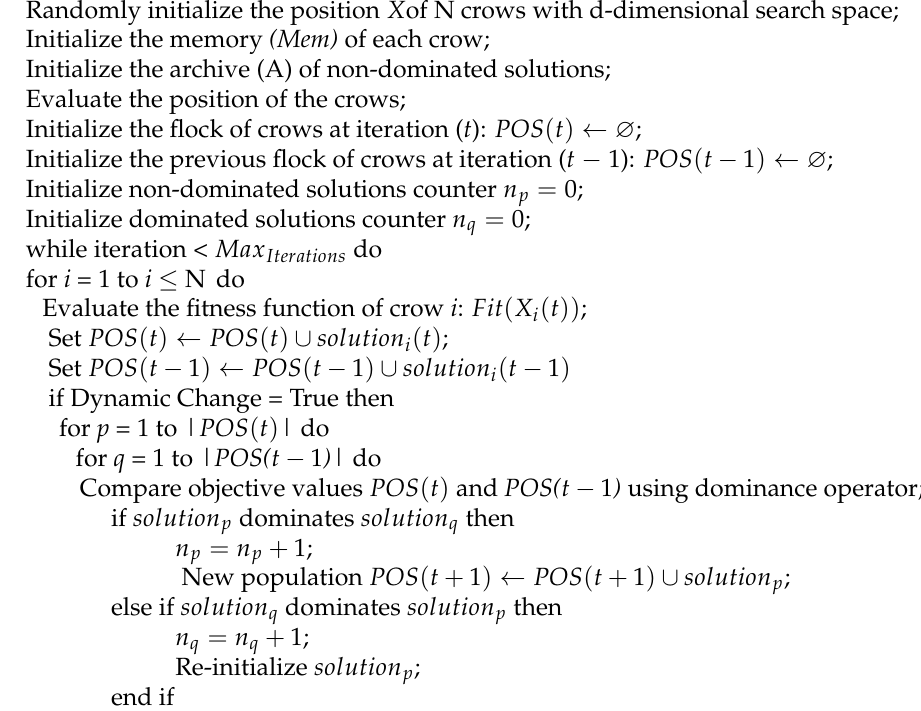
Algorithm 3 The DB-CSA-II Algorithm with Dynamic Optimization